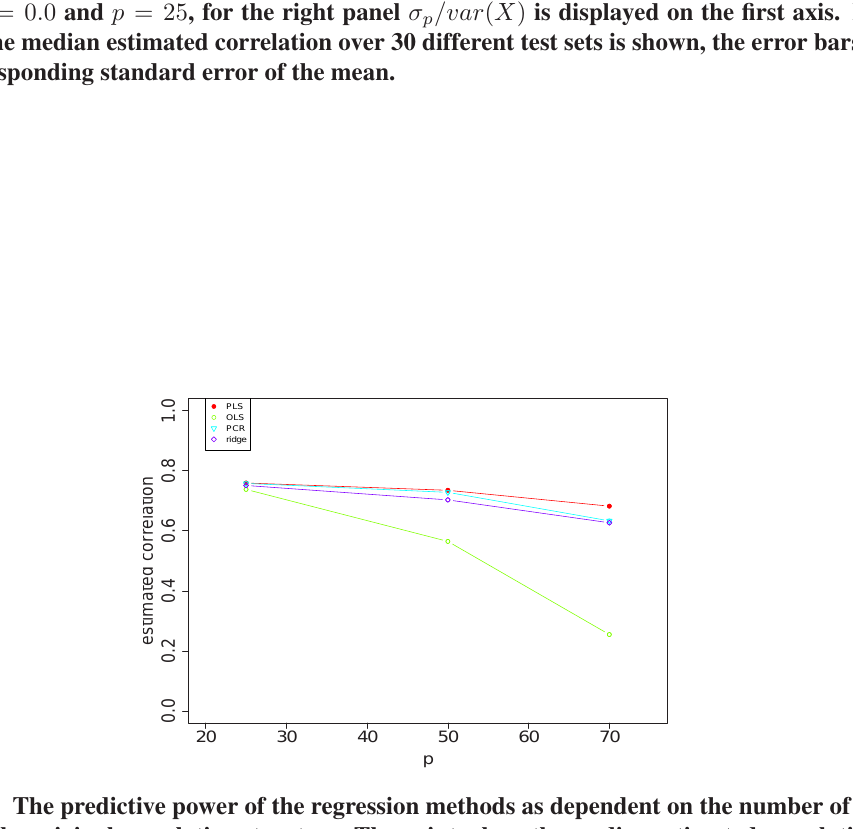
Figure 4: The predictive power of the regression methods as dependent on the number of predic- tors, for the original correlation structure. The points show the median estimated correlation over 30 different test sets, the error bars the corresponding standard error of the